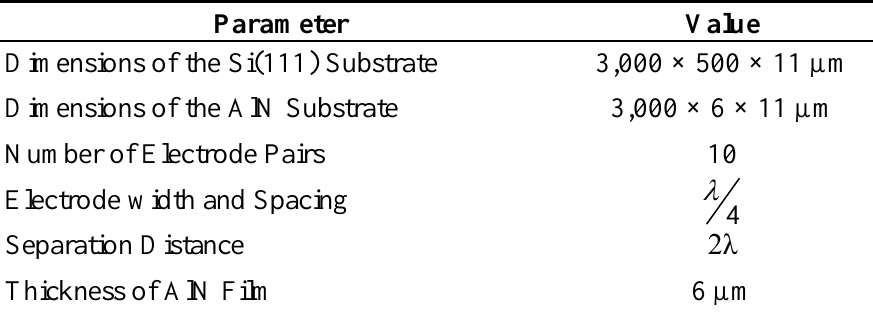
Table 2. Parameters of the AlN/Si(111) FE models adopted in this